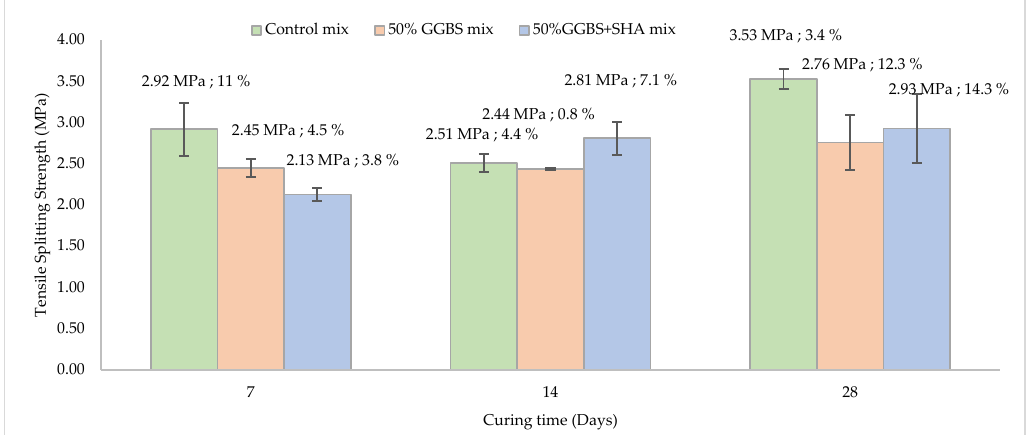
Figure 7. Mix comparison (Tensile Splitting Strength; Coefficient of variation). A contraction of the control mix is noticeable from the 7 to 14 days where, within the range of the coefficient of variation, the mean tensile splitting strength value is seen to re- duce from 2.92 MPa to 2.51 MPa. On a smaller scale, the same seems to happen in the same time frame but regarding the 50% GGBS mix. Since there was an expectation of constant increase throughout the timeframe, the experiment was repeated with similar results. Regarding the 50% GGBS mix, an overall increase of around 13% from the 7-day mark to the 28 was observed. As the above figure demonstrates, the progression of the tensile strength is visibly lower than the control mix throughout the 28 days. Concerning the 50% GGBS mix with the self-healing agent, the same trend of reduced values is observed compared to the control mix. Throughout the 7 to 28 days, a positive evolution of 38% in tensile splitting strength is registered. Once again, following the trend of Figure 6, it is seen that adding the self-healing agent further drops the mechanical properties of concrete, in the case of Figure 7, only surpassing the 50% GGBS mix at 28 days. Since there were no visible cracks on the exte- rior, it is assumed that some internal voids might have been filled with calcium carbonate, making the specimens slightly denser, or the bacterial feed containing calcium lactate might have changed the chemical or crystalline structure of the concrete, but overall acting like a concrete retarder. 3.3. Flexural Strength The following Figure 8 displays the evolution and the variation of flexural strength at 7, 14 and 28 days.